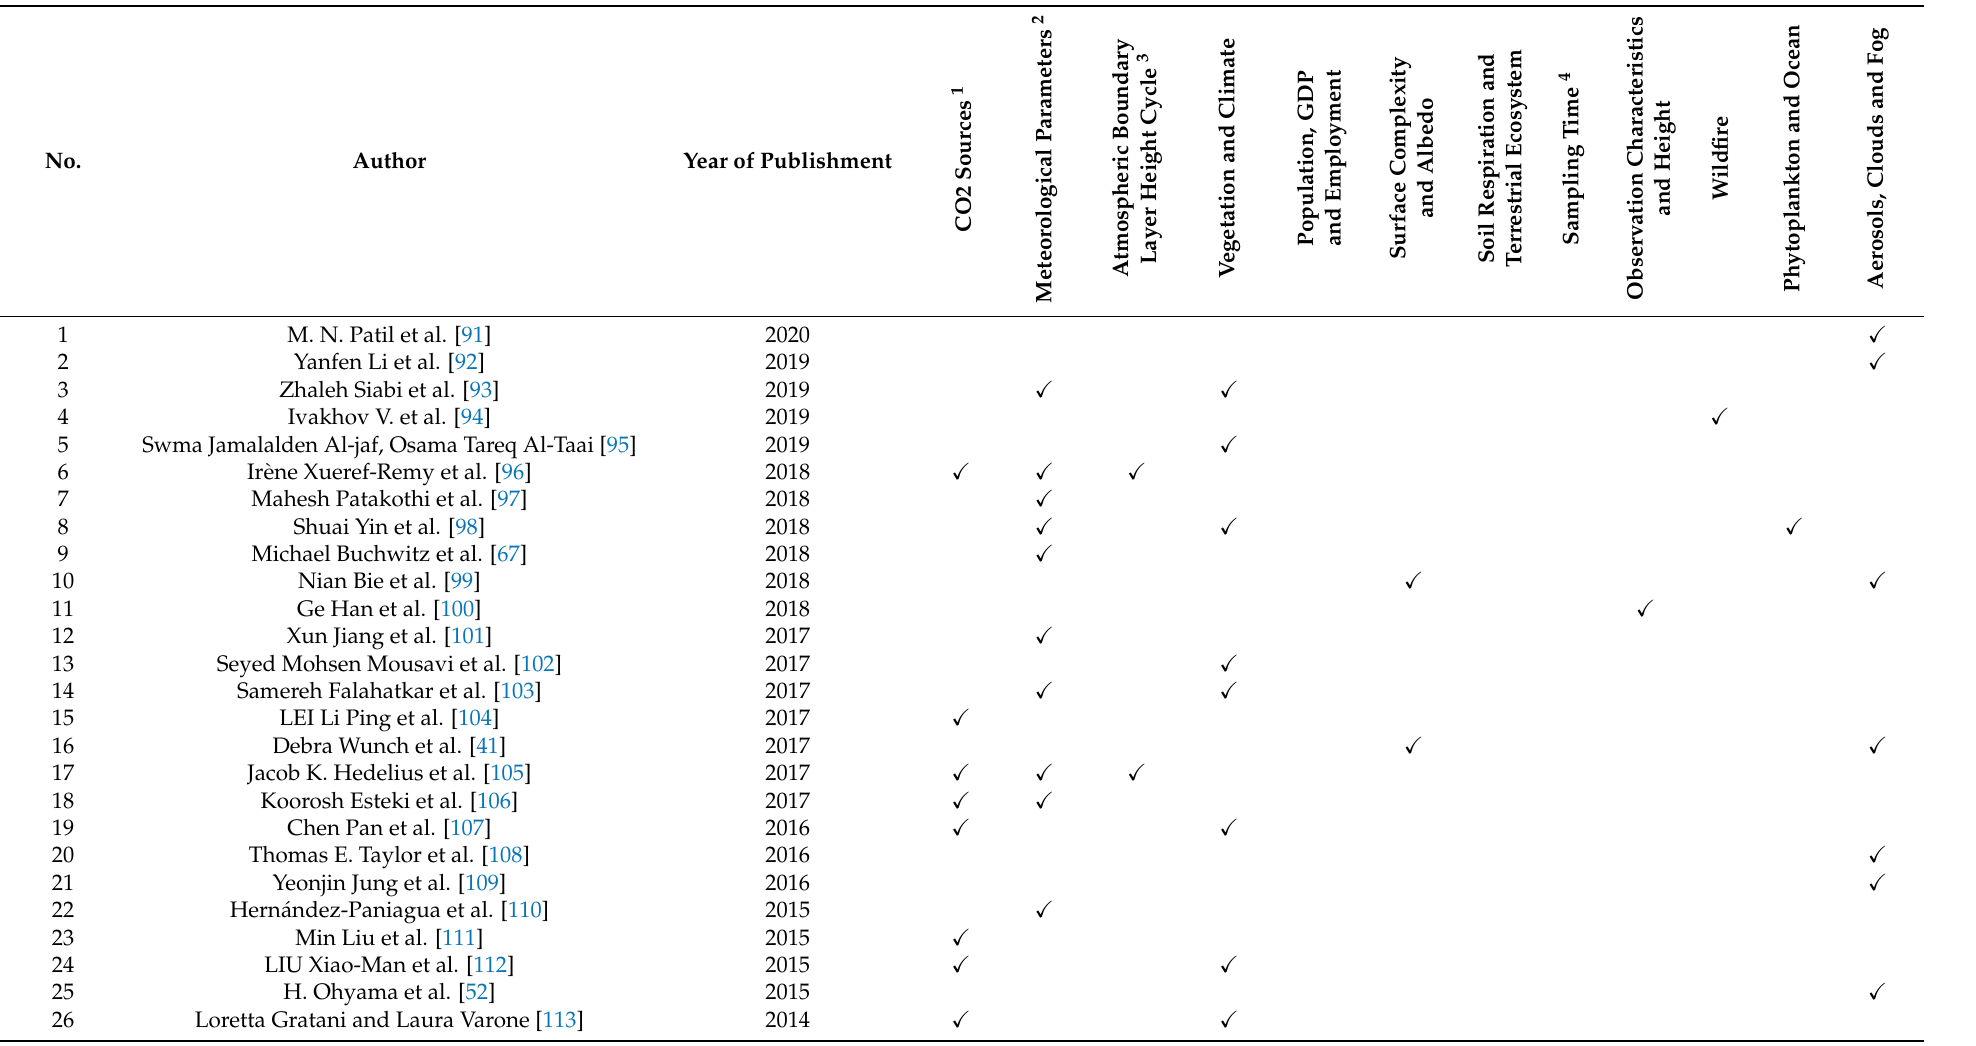
Table A2. Effective parameters on carbon dioxide